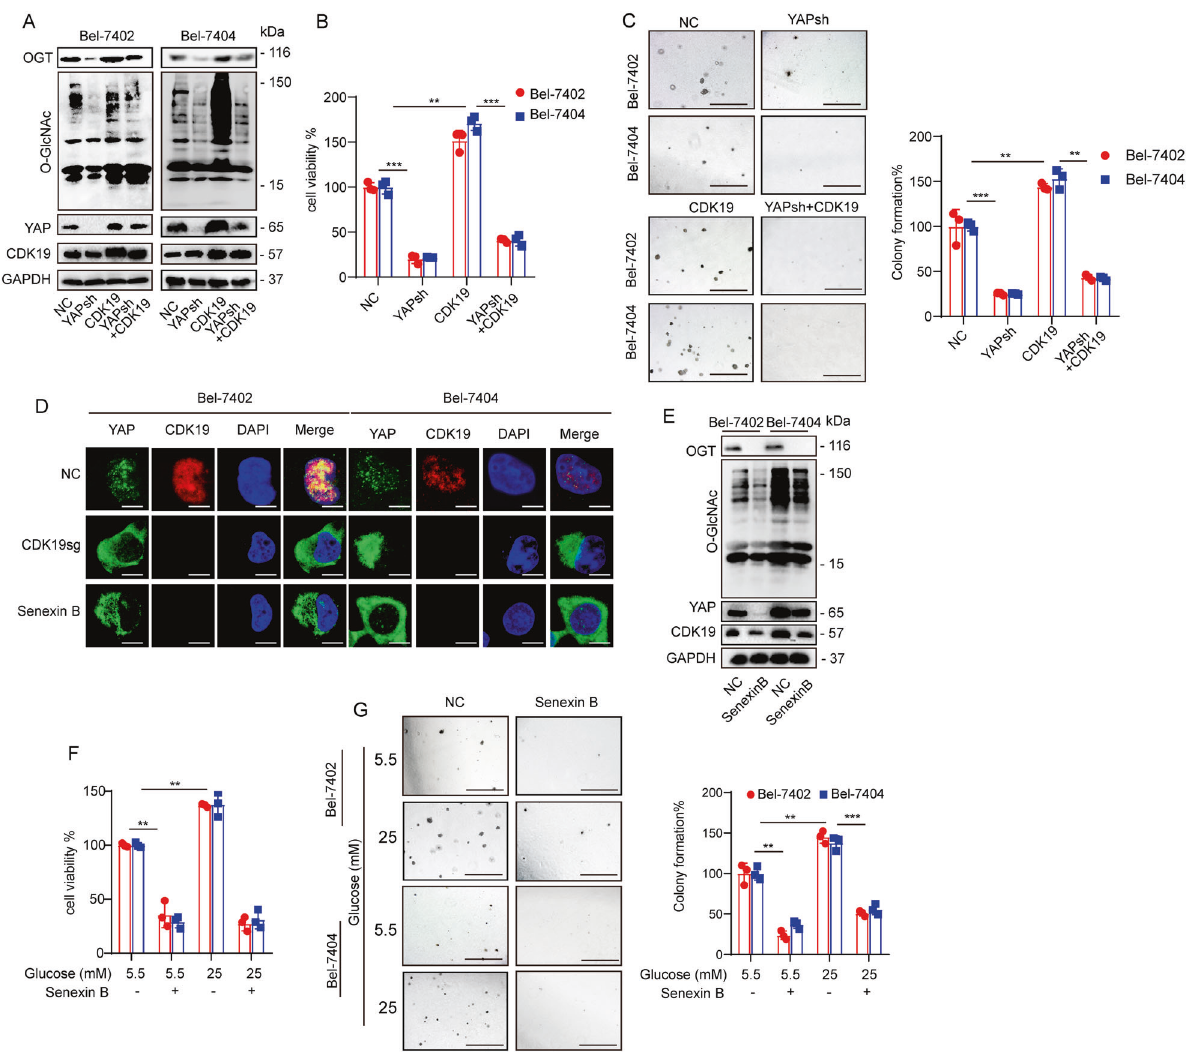
Fig. 6 A – C The protein expression of OGT, O -GlcNAc, YAP, and CDK19 was measured by WB in cells subjected to the indicated treatments ( A ). Cell proliferation and colony-formation capacity were measured with CCK-8 cytotoxicity tests ( B ) and soft agar colony-formation assays ( C ), respectively, in Bel-7402 and Bel-7404 cells subjected to different treatments as indicated. Scale bar, 500 mm. D Subcellular localization of YAP and CDK19 in Bel-7402 and Bel-7404 cells subjected to the indicated treatments. Scale bar: 20 μ m. E OGT, O -GlcNAc, YAP, and CDK19 in Bel- 7402 and Bel-7404 cells subjected to different treatments as indicated were measured by WB. F , G Cell proliferation and colony-formation capacity were measured with CCK-8 cytotoxicity tests ( F ) and soft agar colony-formation assays ( G ), respectively, in Bel-7402 and Bel-7404 cells subjected to different treatments as indicated. Scale bar: 500 µm. Data are shown as mean ± SD. ** P < 0.01, *** P <